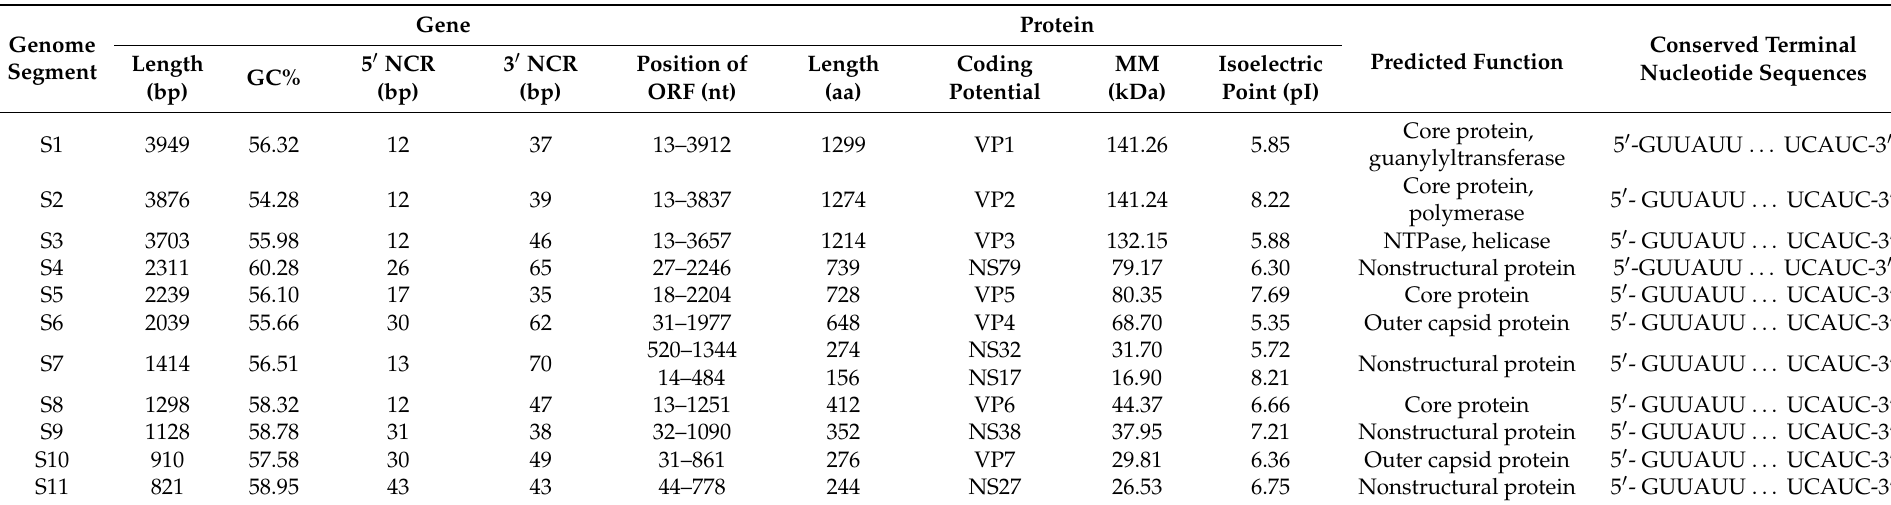
Table 2. Characteristics of genome segments, predicted functions of proteins, and conserved terminal sequences in